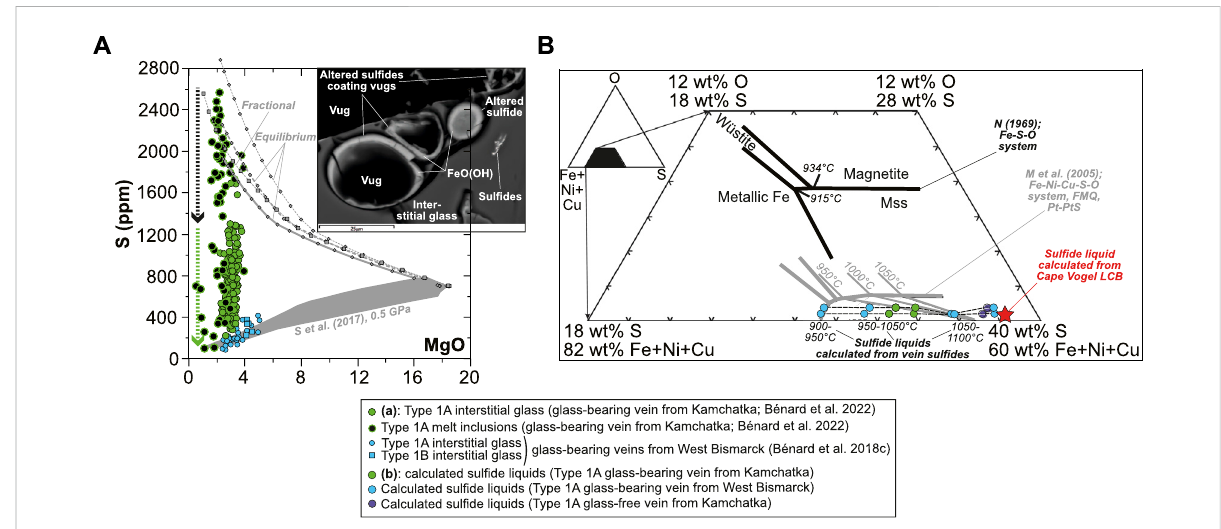
FIGURE 12 Sulfursaturationstateandsul fi deliquidphaserelationsinferredforKamchatkaandWestBismarckType1Aveins. (A) Sabundancesmeasuredby EPMA and SEM in vein MI and interstitial glass plotted against MgO (in wt%; Bénard et al., 2018c; Bénard et al., 2022). Data are compared with the liquidlinesofdescentofspinelharzburgite-derivedmeltsat1 GPa,calculatedbyBénardetal.(2018c)withpMELTS.Thesemodelsareeithercoupled with SCSS calculations using themodel ofSmytheetal. (2017)at 0.5 GPa to simulate sul fi de-saturated conditions (gray fi eld), or assume that all S remains dissolved in the silicate melt (i.e., sulfur is treated as a perfectly incompatible element) to simulate sul fi de- or sulfate-undersaturated conditions (gray lines). The inset is a BSE image (SEM) illustrating the magmatic (sul fi des in interstitial glass) and hydrothermal (vugs coated with sul fi des altered into Fe oxyhydroxide) origins of vein sul fi des (scale bar is 25 μ m). (B) Projection of the LCB sul fi de liquid estimates in a portion of the triangularFe(±Ni,Cu)-S-Oplane.DataareshownincomparisonwithexperimentalphaserelationsfortheFe-S-Osystem(blacklines;Naldrett,1969) and the Fe-Ni-Cu-S-O system (gray lines; Mungall et al., 2005). Sul fi de liquids calculated from the compositions of the vein sul fi des in this study (colored dots) and from the compositions of Cape Vogel LCB (red star; König et al., 2010) are shown (see text for